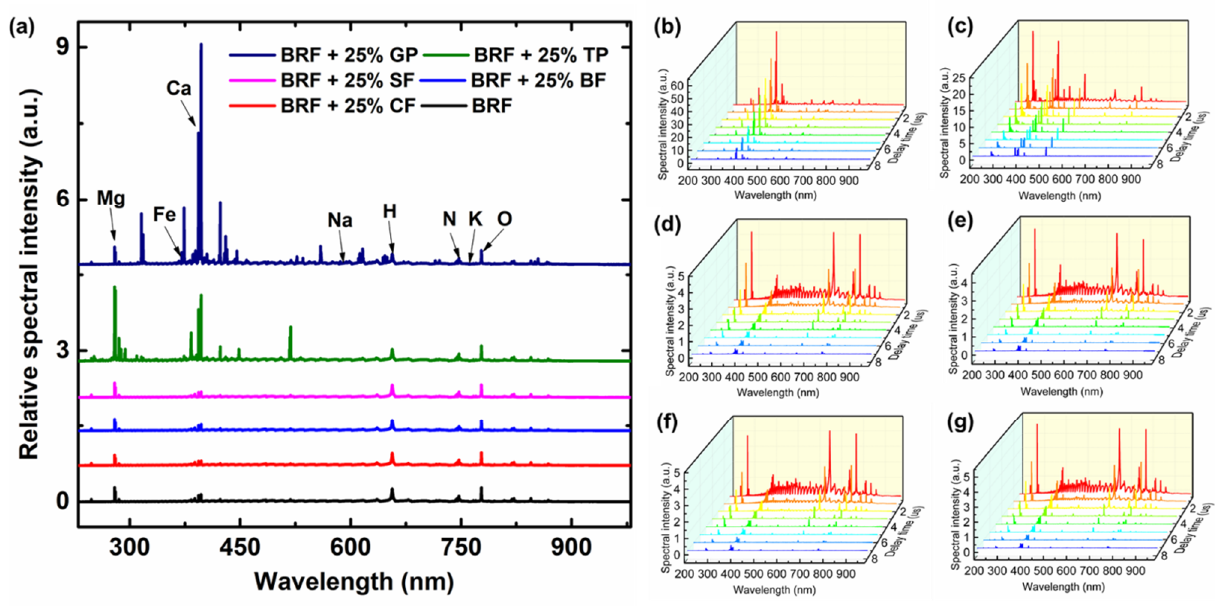
Figure 2. ( a ) LIBS spectra and ( b – g ) time-resolved spectra of BRF with 25% GP, BRF with 25%